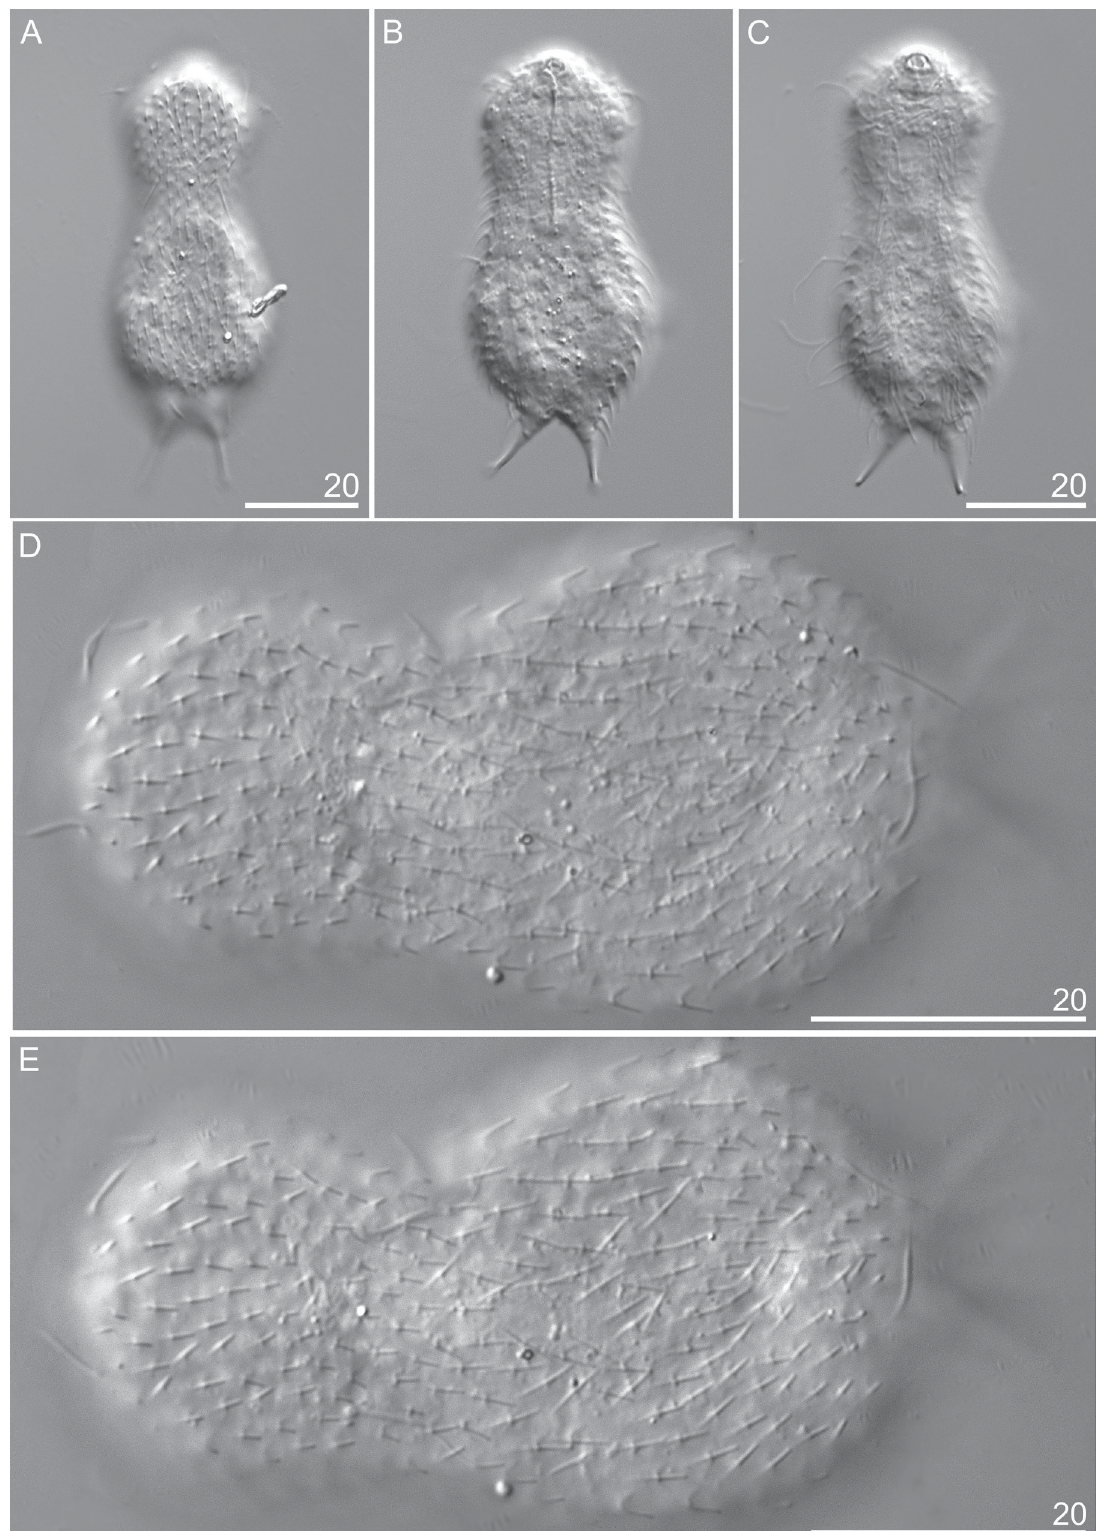
Fig. 10. Chaetonotus (Chaetonotus) antrumus Kolicka sp. nov., juvenile specimen, differential interference contrast microphotographs. A . Body, dorsal view. B . Body, internal view. C . Ventral body view. D . Dorsal view of scales. E . Dorsal view of